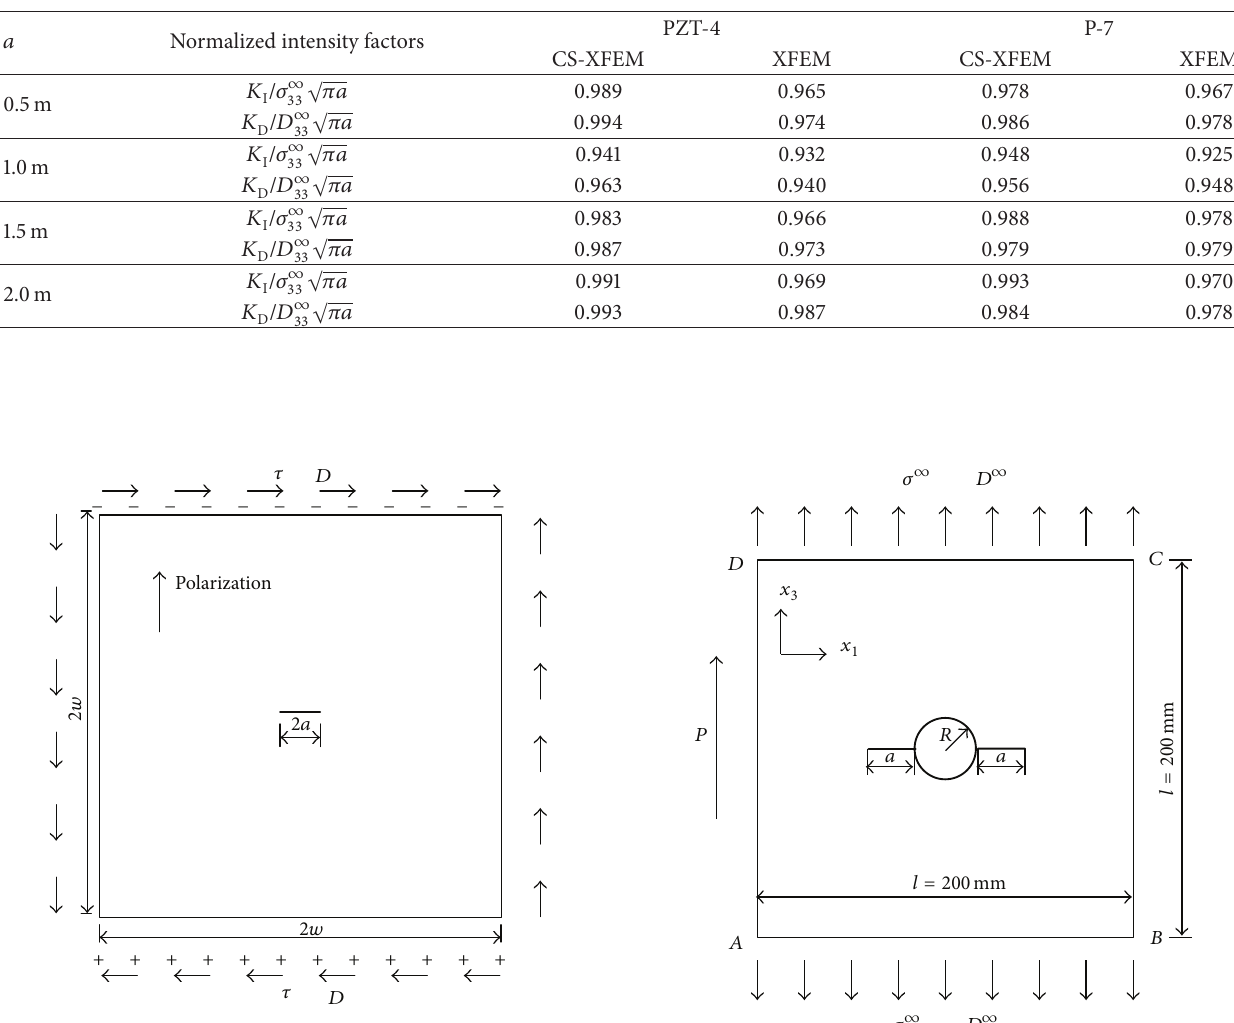
Figure 8: Electromechanical Griffith crack (uniaxial load).